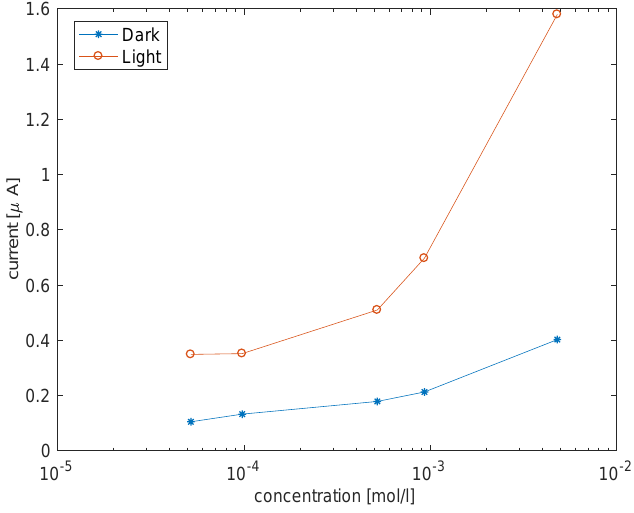
Figure 9. Variation of the current in a voltammetric setup as a function of the concentration of cysteine in the dark and under visible light. The voltage was kept fixed at 0.8 V. Data from reference [29].